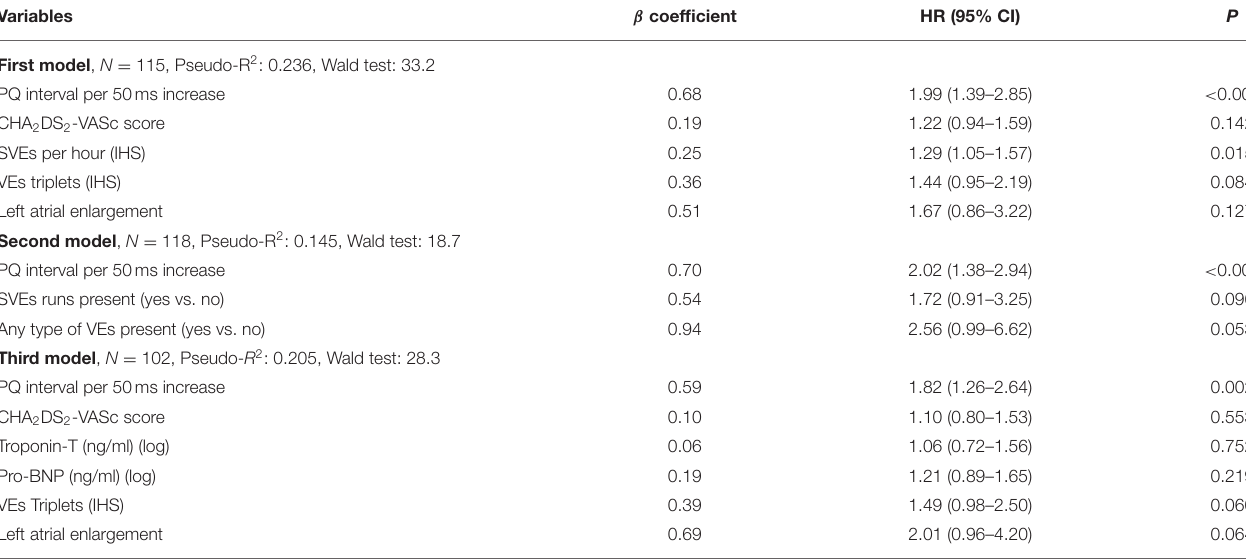
TABLE 2 | Multivariate cox-proportional hazard analysis of predictors for atrial fibrillation in 131 patients with embolic stroke of undetermined source. Variables β coefficient HR (95% CI)